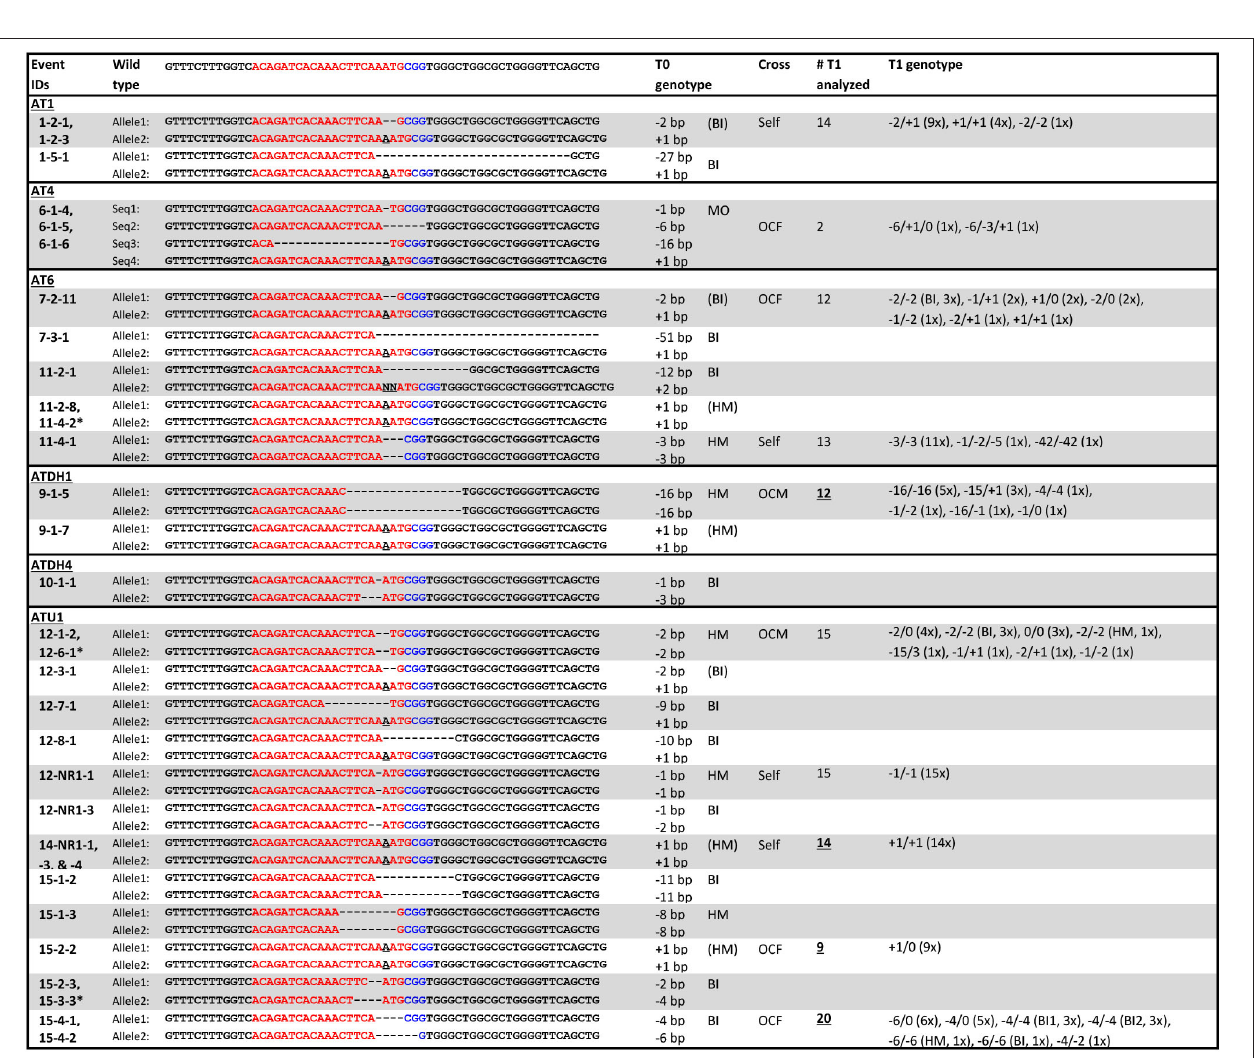
FIGURE 6 | Genotypes of selected T0 and T1 mutants. Red letters, target sequences in Gl2 exon 2; Blue letters, PAM sequences; Black letter with underscore, insertion mutations; AT1, AT4R, AT6R, ATDH1, ATDH4, and ATU1, FFMM-AT genotypes; Event marked with star, separate event that had the same mutation pattern; BI, biallelic; HM, homozygous; MO, mosaic; (BI) and (HM), events with same mutation pattern in more than one sampled T0 plant; Self, self-pollination; OCF and OCM, an outcross with the T0 plant used as a female or male, respectively; Underlined numbers, T1 progenies of T0 plants of which their sibling T0 plants from the same transgenic event were sequenced; T1 genotypes, numbers in parentheses indicate the numbers of plants from the event that have the same mutation